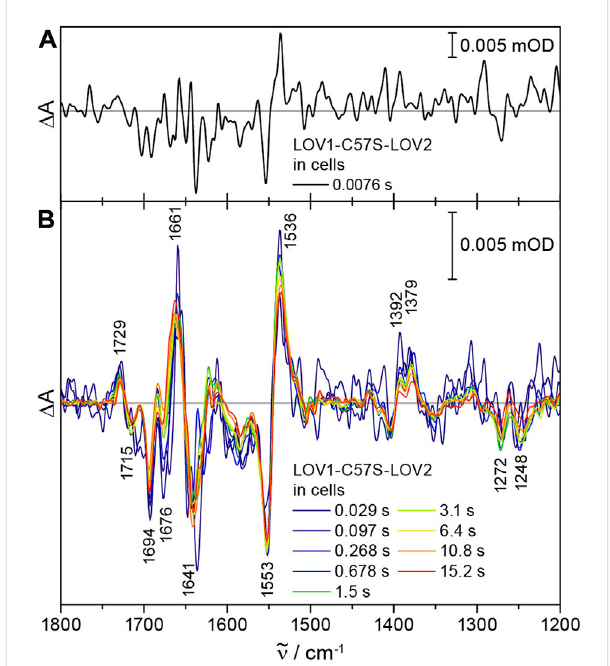
FIGURE 4 Time-resolved ICIRD spectra on the model protein LOV1-C57S- LOV2from Cr Photin E.coli cells. (A) At7.6 ms,characteristicsignalsof the photoreaction are already resolved. (B) The difference spectra after laser excitation show changes in secondary structure elements at1676( − )cm − 1 andtheadduct decay inthemillisecond and second time range,